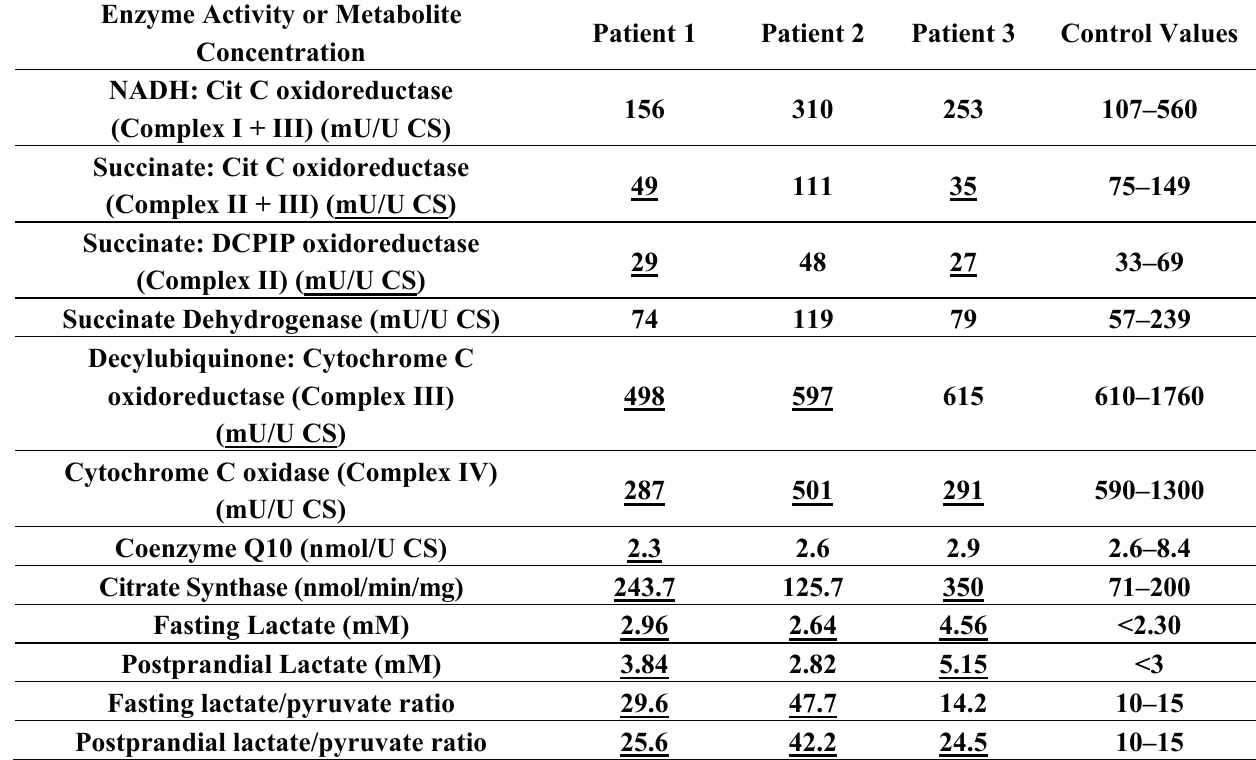
Table 2. Metabolic energy study performed on muscle biopsy samples. The enzymatic activity of mitochondrial respiratory chain complexes (I–IV) was corrected for the presence of citrate synthase (CS). Succinate dehydrogenase activity was assessed in the presence of phenazine methosulfate, which acts as part of the electron transfer system. The measurement unit for each enzyme/complex activity was mU/U, and this was normalized to CS activity. Lactate values and the lactate/pyruvate ratio found in the plasma are shown. Values that are underlined represent those that are outside the normal range for children without mitochondrial